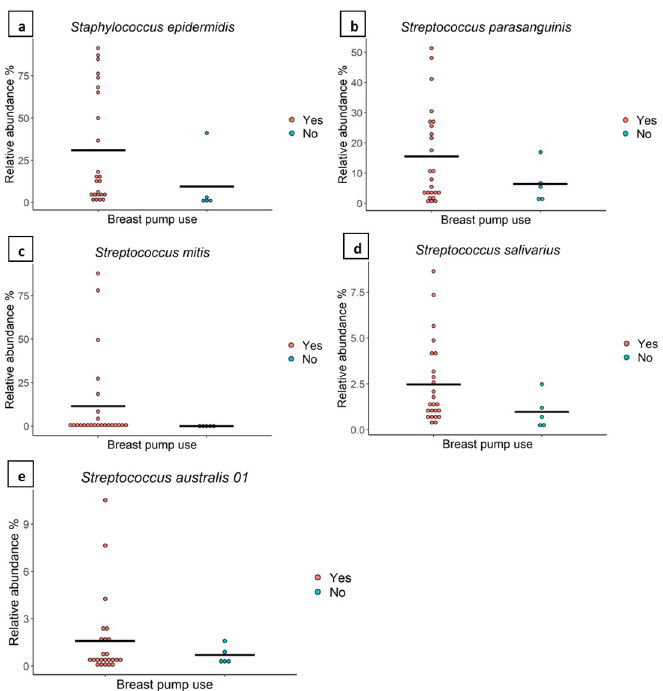
Fig 4. The relative abundance of Streptococcus spp. and Staphylococcus sp. is associated with breast pump use. The relative abundance of various bacterial taxa in milk from mothers who did (n = 24) or did not (n = 5) use a breast pump. The average value for each group is indicated with a